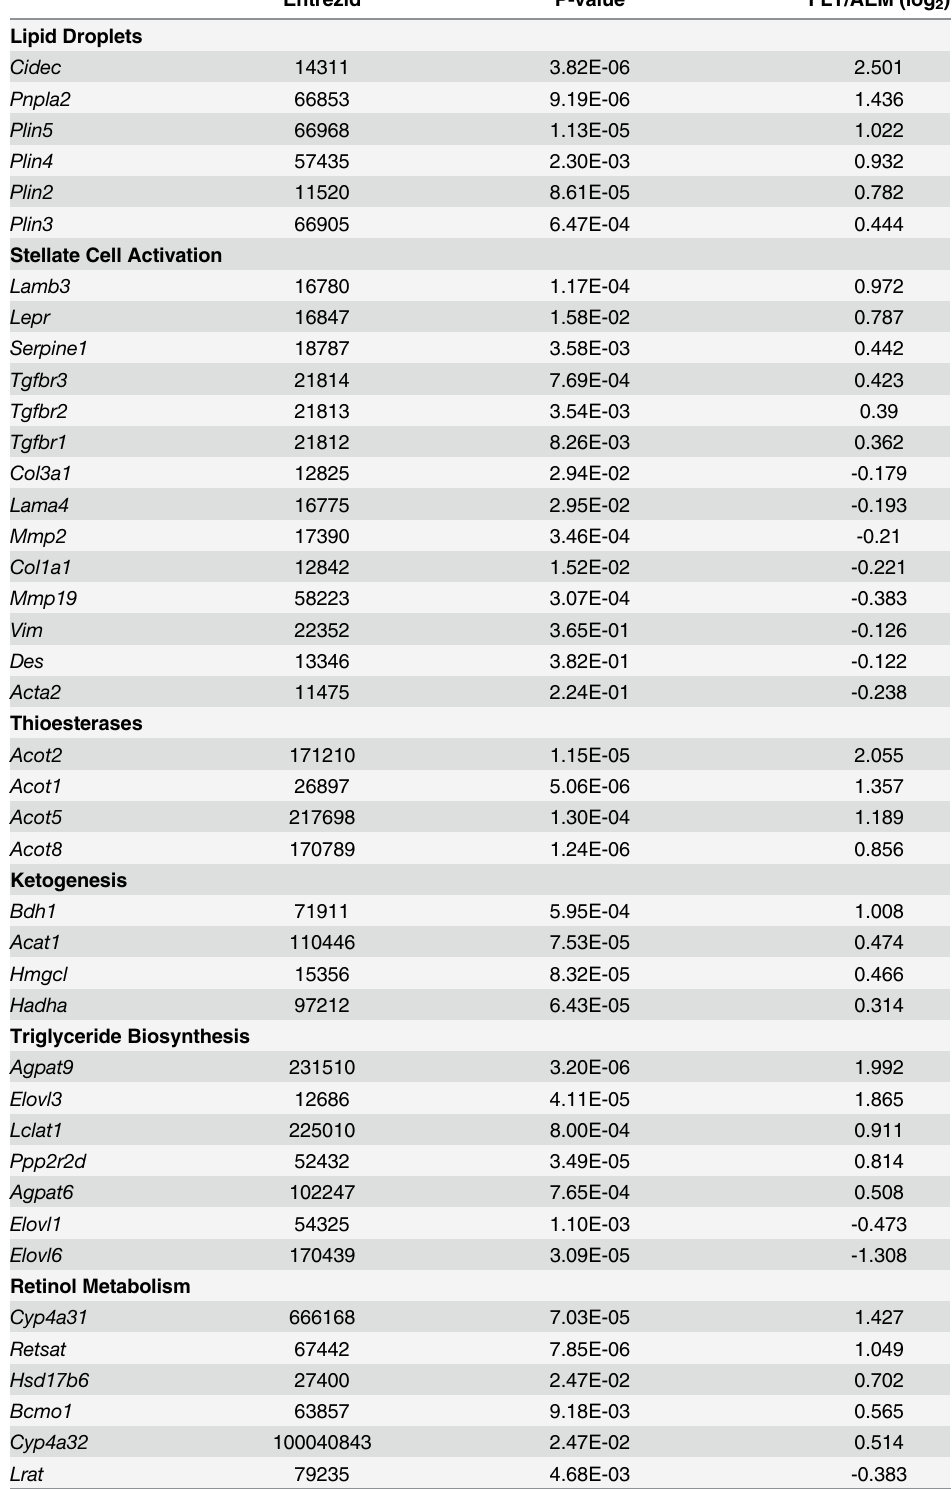
Table 2. mRNA expression changes for selected